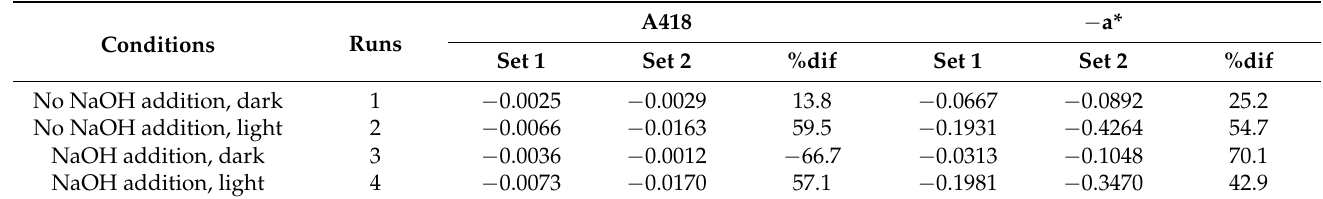
Table 1. Degradation rate (slope) of Chl a and green color ( − a*) of 4 experiments of each set of experiments at 4 ◦ C for the first 48 h. Set 1 refers to the first batch of experiments (lower concentration, 0.6 of initial absorbance), set 2 refers to the second batch of experiments (high concentration, 1.8 of initial absorbance), and %dif refers to the difference between both sets expressed in percentage.